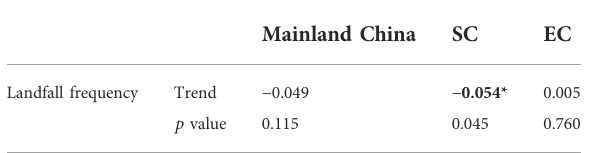
TABLE 1 The linear trends and corresponding p values for the annual landfall frequency of TCs over mainland China, SC, and EC from 1980 to